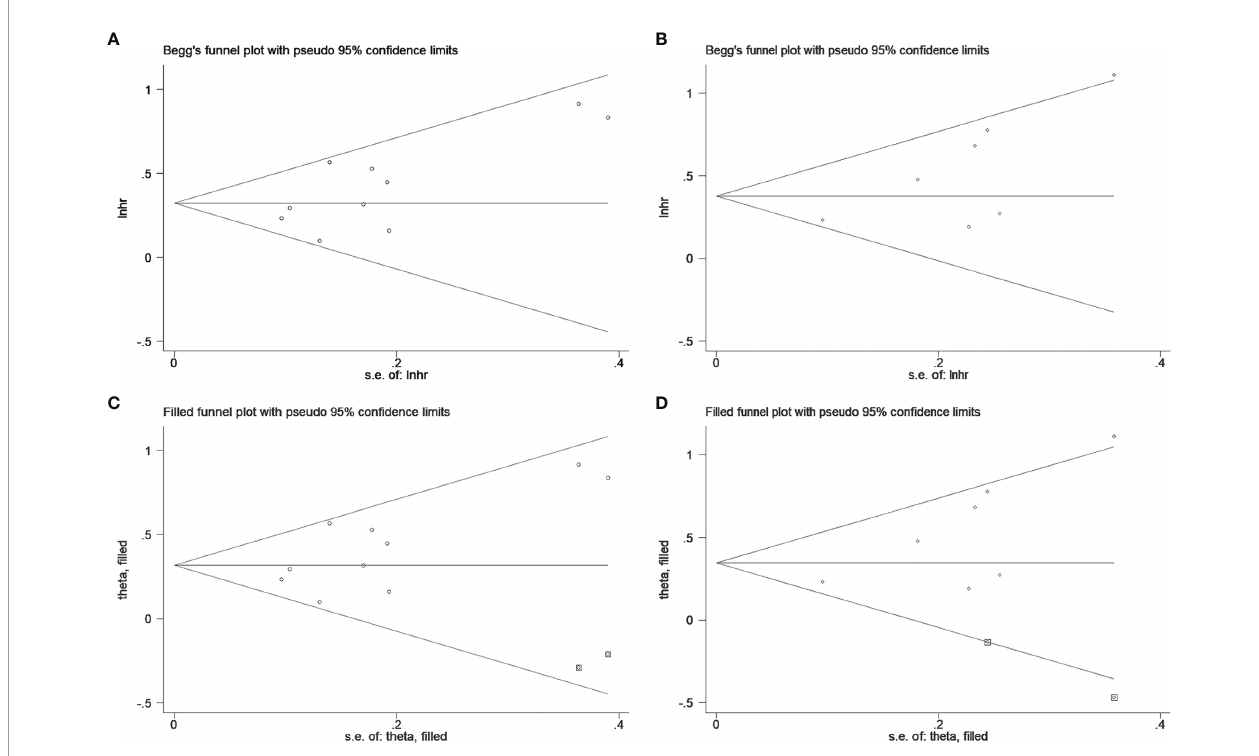
FIGURE 4 | Begg ’ s test for (A) overall survival and (B) cancer-speci fi c survival; Trim and fi ll method for (C) overall survival and (D) cancer-speci fi c